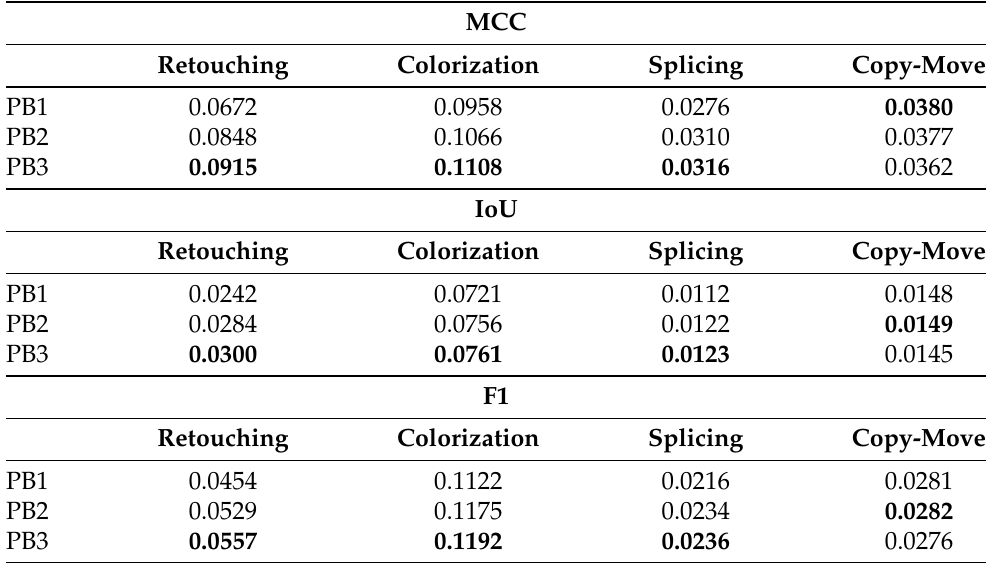
Table 2. MCC, IoU and F1 scores for our method with one scale (PB1), two scales (PB2) and three scales (PB3).